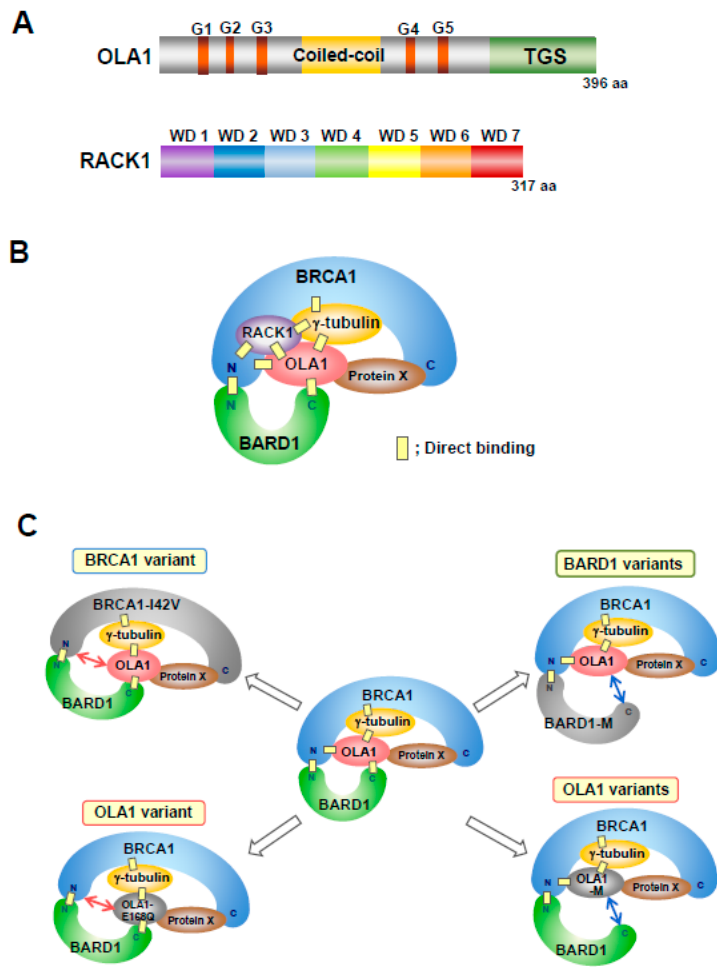
Figure 3. ( A ) Structure of Obg-like ATPase 1 (OLA1) and receptor for activated C kinase (RACK1). OLA1 is a member of the Obg family and YchF subfamily of P -loop GTPases, and is composed of a central guanine nucleotide-binding domain (G domain), flanked by a coiled-coil domain and a TGS domain. The G domain is the basic functional unit of GTP-binding proteins (G proteins) and contains five characteristic sequences (G1–G5) that are involved in nucleotide binding and hydrolysis. RACK1, a member of the Trp-Asp (WD) repeat protein family, is composed of seven WD domains that adopt β -propeller structures. ( B ) Model of the BRCA1/BARD1/OLA1/RACK1 complex. OLA1 binds to the N-terminal region of BRCA1, the C-terminal region of BARD1, and γ -tubulin. The N-terminal region of BRCA1 binds to the N-terminal region of BARD1. The middle portion of BRCA1 interacts with OLA1 via γ -tubulin. The C-terminal region of BRCA1 may be associated with OLA1 via an unknown protein, Protein X. RACK1 directly binds to OLA1, the N-terminal region of BRCA1, and γ -tubulin, and it is associated with BARD1. “N” indicates the N-terminal region. “C” indicates the C-terminal region. ( C ) Model of the conformational changes of the BRCA1/BARD1/OLA1/ γ -tubulin complex induced by variants of BRCA1, BARD1, or OLA1. The N-terminal region of BRCA1 with the I42V variant shows markedly decreased binding to OLA1. OLA1 with the E168Q variant does not bind to the N-terminal region of BRCA1. These missense substitutions cause similar alterations in the conformation of the protein complex. The OLA1 mutations (M) S36A, S36C, F127A, and T325A abolish binding to the C-terminal region of BARD1. The BARD1 variants C645R, V695L, and S761N abolish binding to OLA1. These missense substitutions cause similar alterations in the conformation of the protein complex. “N” indicates the N-terminal region. “C” indicates the C-terminal region. These variants cause centrosome amplification. Abnormal formation of the complex is involved in carcinogenesis. BARD1-M; C645R, V695L, or S761N. OLA1-M; S36C, S36A, F127A, or T325A.